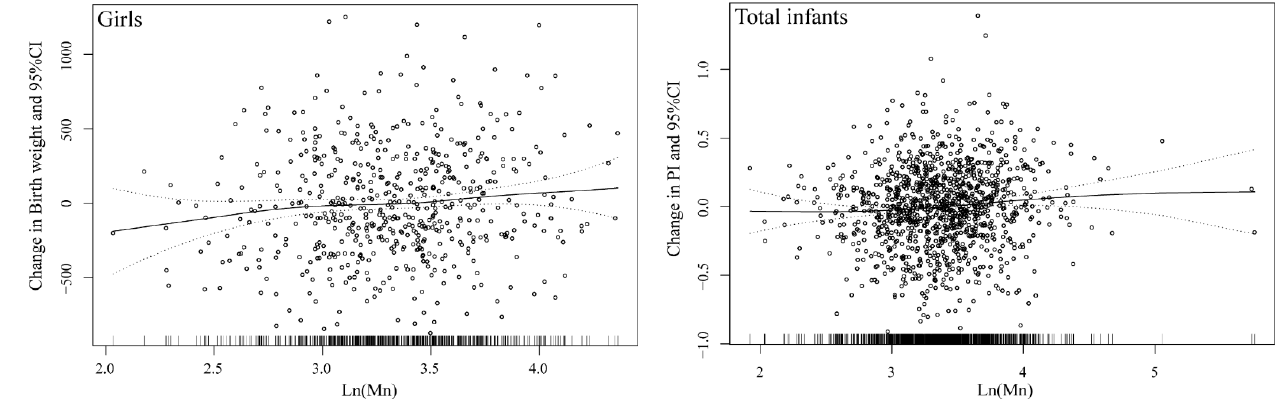
Figure 1. Generalized additive models for associations between prenatal Mn exposure and birth outcomes.